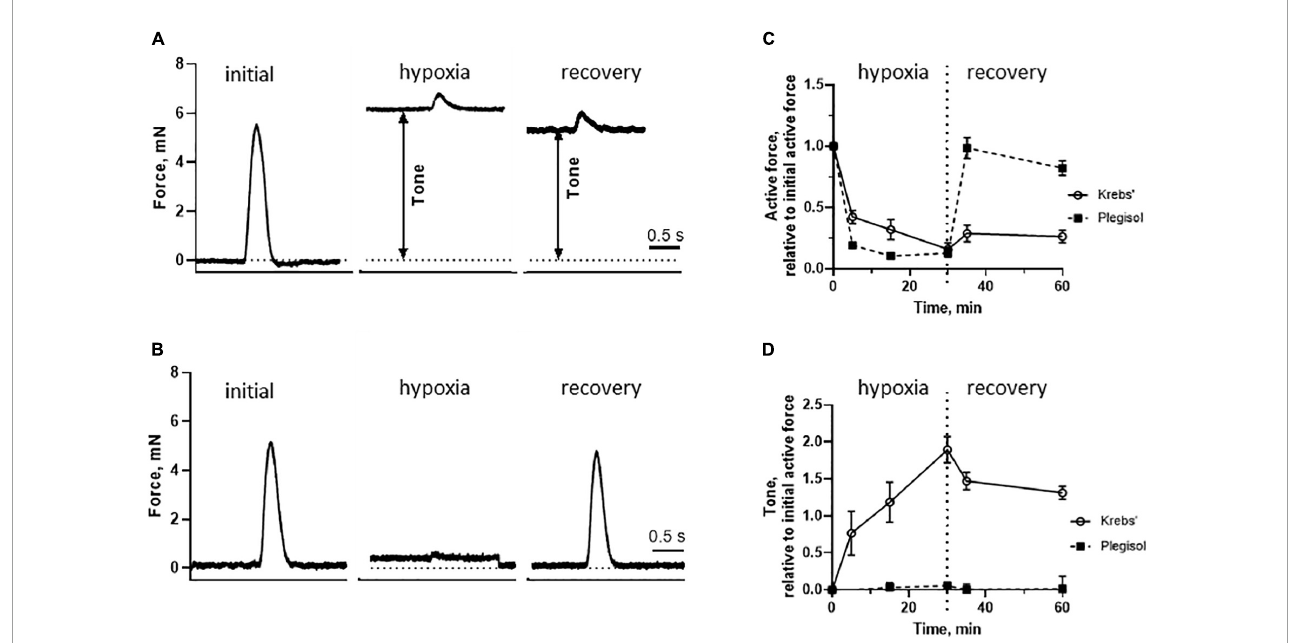
FIGURE6 In vitro force measurements from paced intact trabecular muscles. Original force trace of a single contraction prior to hypoxia/ischemia, at the end of a hypoxia period and at the end of a recovery period (left to right). The preparation in panel (A) was treated with glucose free Krebs’ solution and the preparation in panel (B) with cardioplegic solution (Plegisol R (cid:13) ) during the hypoxia/ischemia period. Initial and recovery periods were both recorded in Krebs’ solution. Summarized data of active force (C) and tone (D) in each group at different times. Hypoxia/ischemia was introduced between 0 and 30 min, followed by recovery for additional 30 min. The Plegisol R (cid:13) group had significantly lower tone during both the hypoxia/ischemia and recovery periods, and higher active force during recovery ( p < 0.05 for both comparisons, repeated measures, ANOVA). N = 4–8 trabeculae in each group (from six animals in each